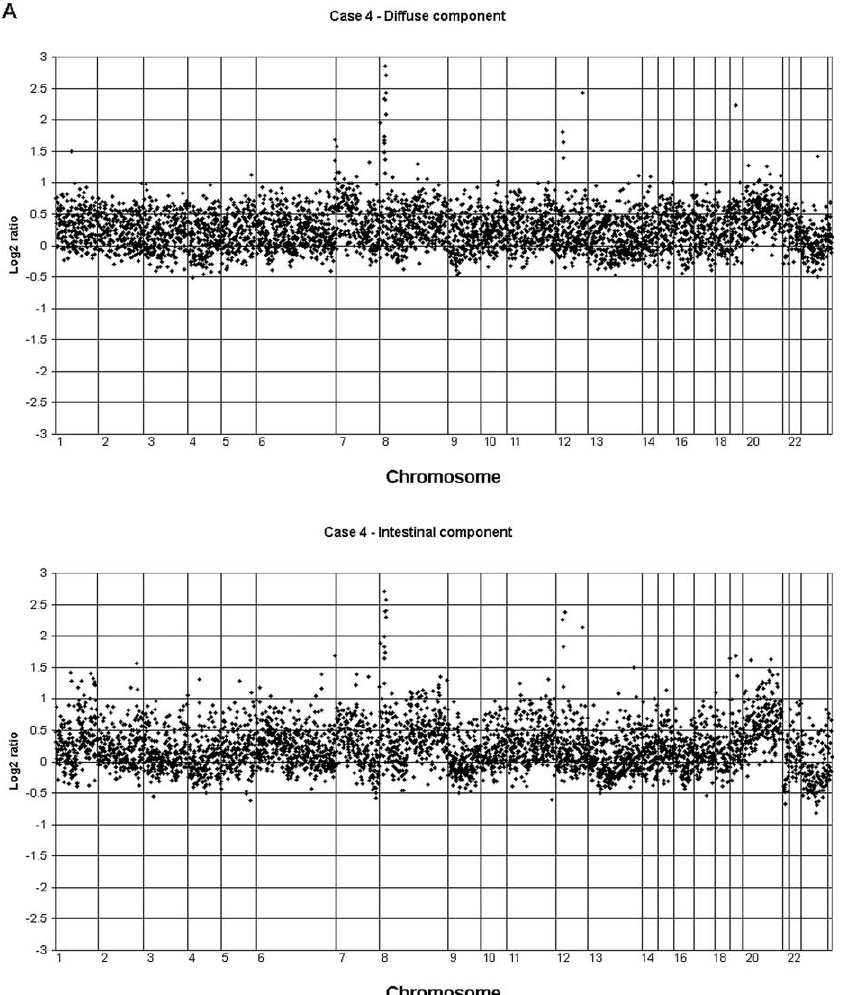
Fig. 5. DNA copy number changes profiles of two mixed gastric cancers, one with high level of noise, (A) case #4, and one with low level of noise, (B) case #7; intestinal and diffuse components analysed separately. Vertical lines – transition between